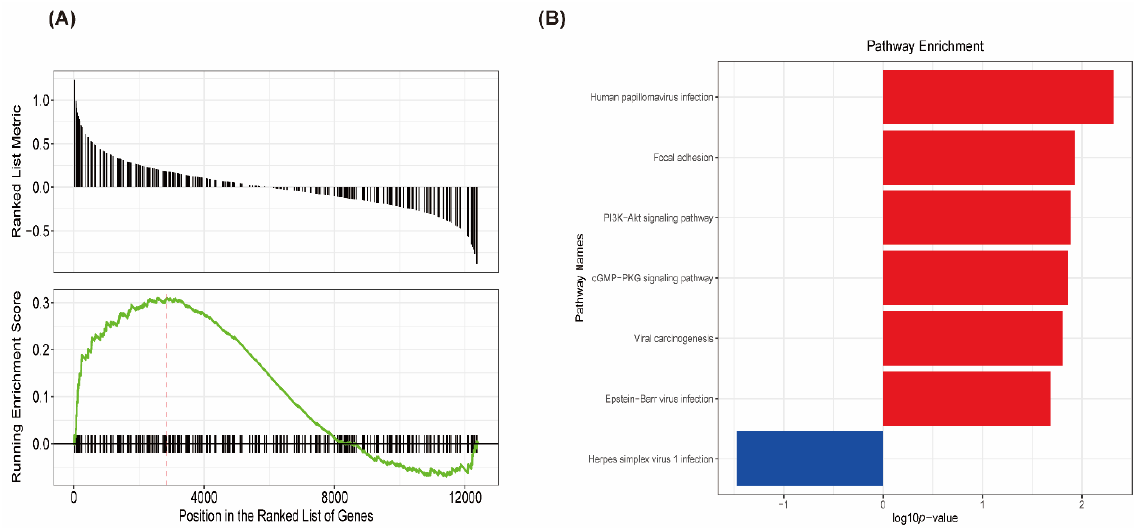
Figure 3. Gene set enrichment analysis (GSEA) and Kyoto Encyclopedia of Genes and Genomes (KEGG) pathway enrichment analysis for GSE120895. ( A ) GSEA revealed the genes were enriched at the top. ( B ) The top terms of the KEGG pathway analysis for GSE120895. The significant pathways are represented by the negative decimal logarithm of the p -value.